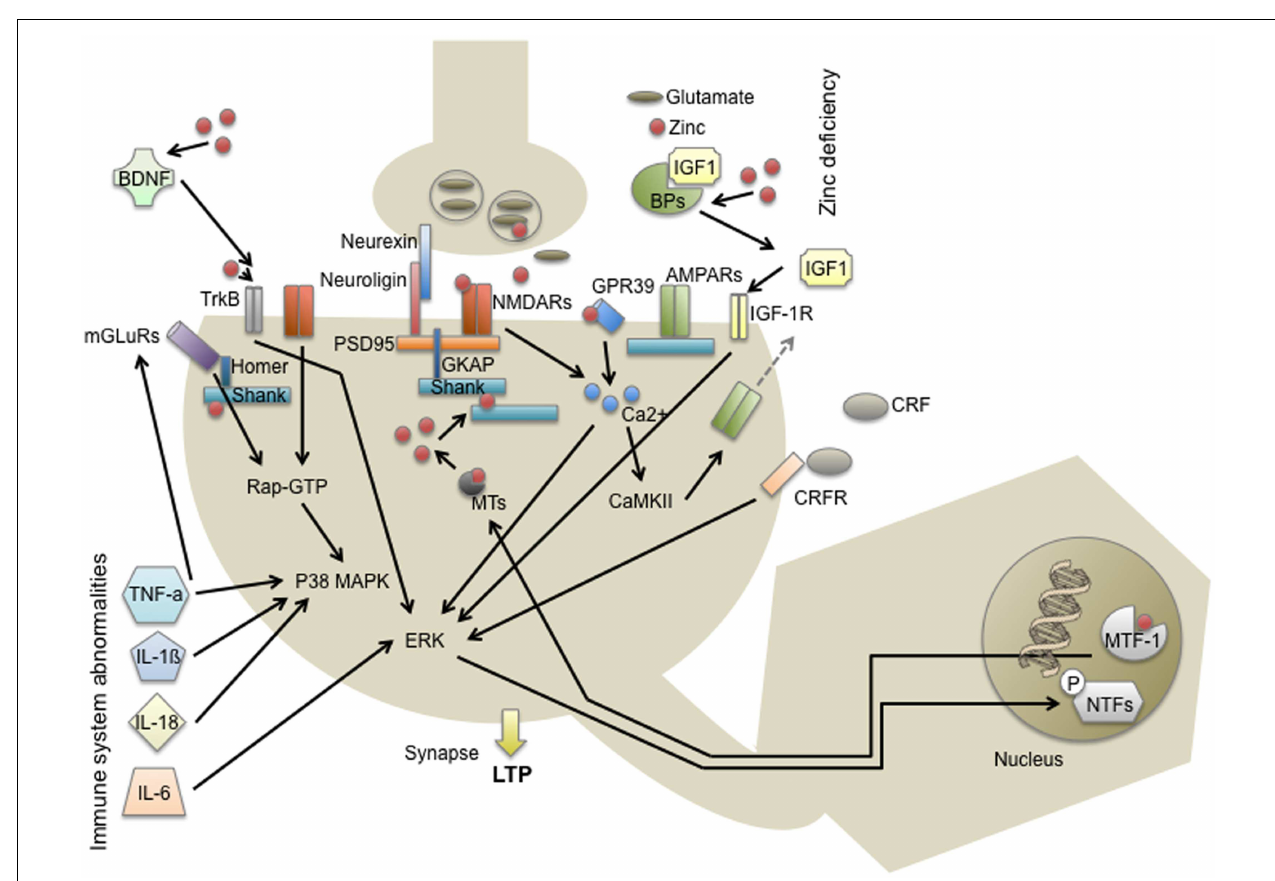
signaling outcome on various levels. Zn 2 + -deficiency for instance might be able to alter the PSD scaffold via Shank2 and Shank3 and additionally influences NMDAR,TrkB receptor, and GPR39 receptor signaling. Moreover, Zn 2 + that might be released from presynaptic vesicles or postsynaptic metallothioneins can affect IGF1 signaling and gene expression via MTF1. Immune system abnormalities, including the expression of cytokines such